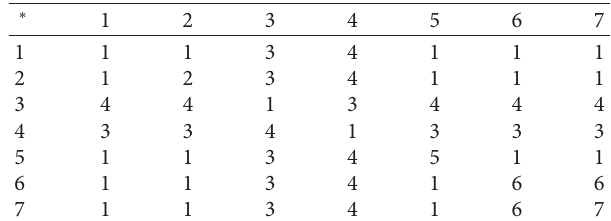
Table 1: Table of Example 1.